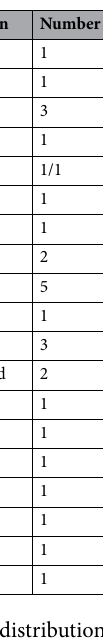
Table 1. The distribution range of syrinx cavity and the number of patients.